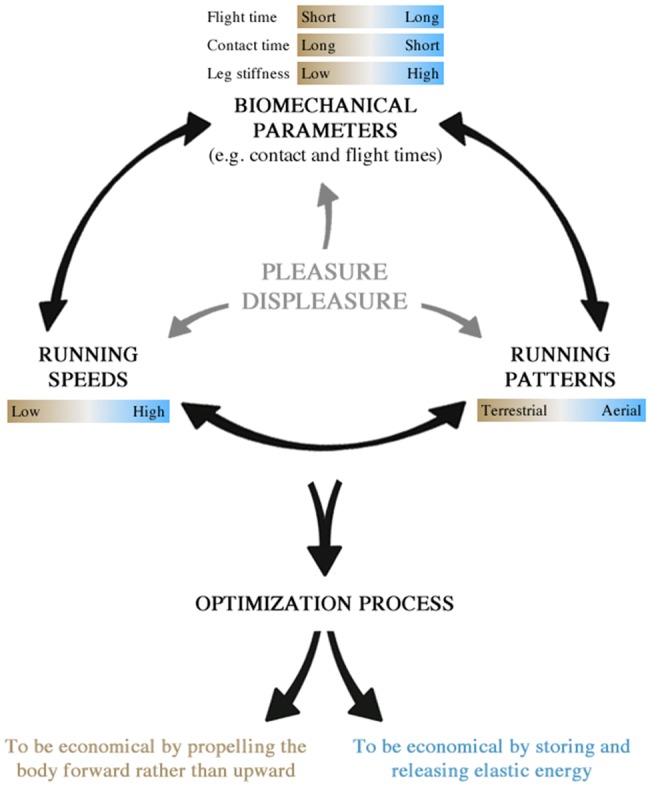
Schematic representation of the interactions within the three-party system. The system is based on three elements including running patterns, running speeds, and biomechanical parameters. Each element can evolve through continuums and lead to different optimization strategies. Finally, the strategies seem to be mediated by the feeling of pleasure-displeasure.